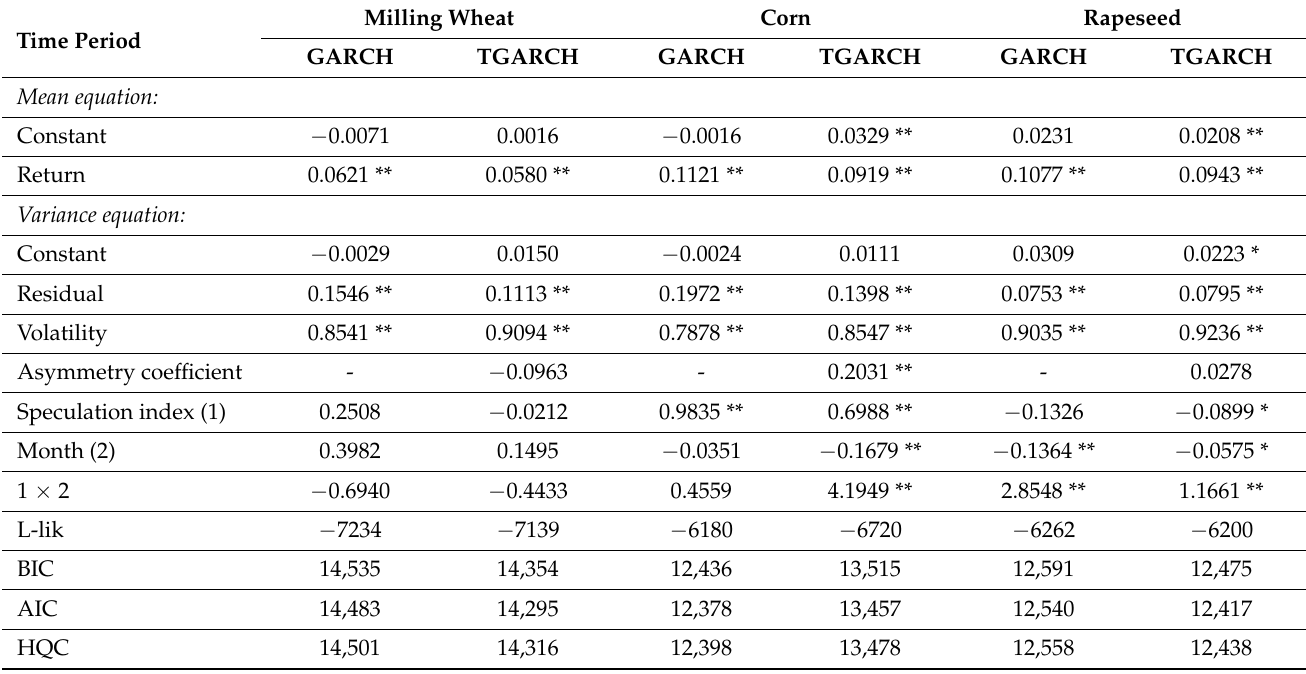
Table 6. Estimates of GARCH commodity-return models using Framework II with a month’s